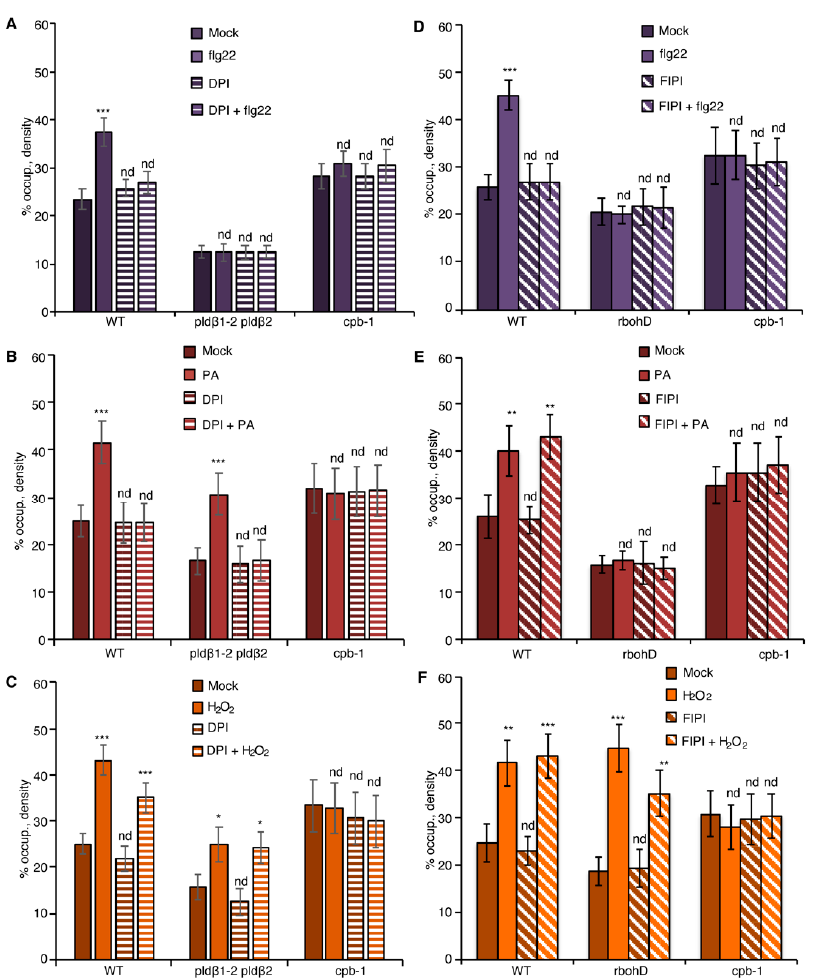
Figure 4. PA regulates actin dynamics through ROS production during PTI. ( A ) Actin filament abundance in WT, pld β 1-2 pld β 2 , and cpb-1 seedlings after treatment with flg22 and/or the NADPH oxidase inhibitor, DPI. In WT, flg22-stimulated actin accumulation was impaired in the presence of 50 µM DPI. However, actin filaments in pld β 1-2 pld β 2 and cpb-1 were insensitive to any treatment. ( B ) Actin filament abundance in WT, pld β 1-2 pld β 2 and cpb-1 seedlings after treatment with PA and/or DPI. PA treatment led to an increase in density of actin filaments in both WT and pld β 1-2 pld β 2 mutant compared to mock. The presence of DPI blocked PA-triggered increases in actin fila- ment density. In contrast, actin filament organization in cpb-1 mutant was unresponsive to either treatment. ( C ) Actin filament abundance in WT, pld β 1-2 pld β 2 , and cpb-1 seedlings after treatment